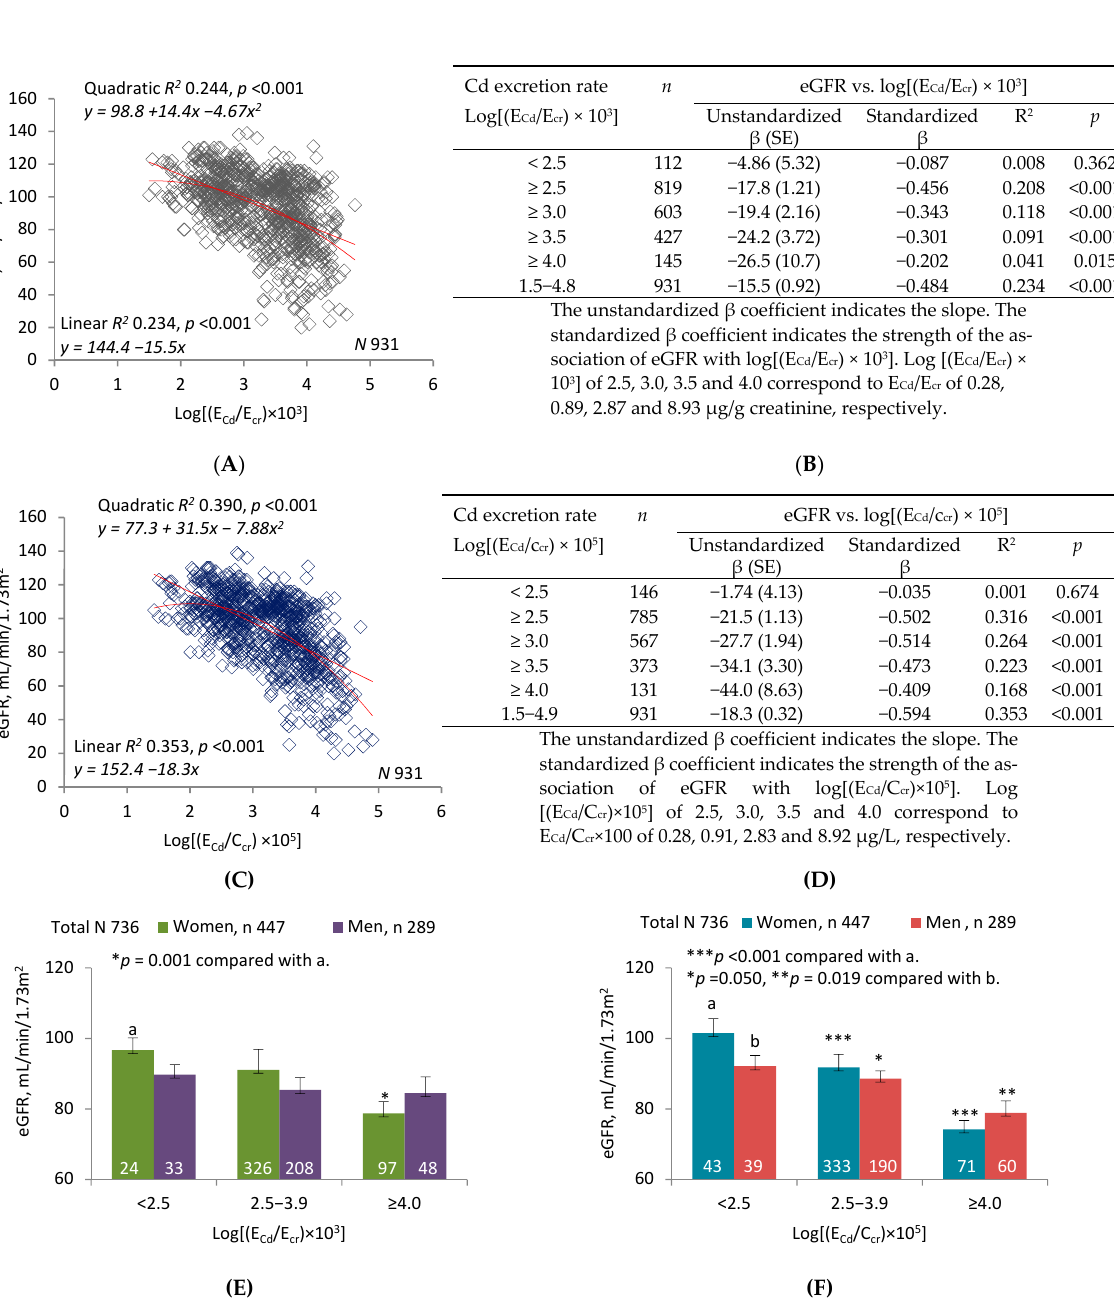
Figure 1. Inverse relationships of eGFR to parameters of Cd excretion. Parameter abbreviations are summarized at the end of the text. Scatterplots in graphs ( A , C ) relate eGFR to log[(E Cd /E cr ) × 10 3 ] and log[(E Cd /C cr ) × 10 5 ] in all subjects. Linear and quadratic equations, their respective coefficients of determination (R 2 ), and associated p -values are provided. In Table ( B ), linear relationships of eGFR to log[(E Cd /E cr ) × 10 3 ] < 2.5, ≥ 2.5, ≥ 3.0, ≥ 3.5 and ≥ 4.0 are characterized with respective values of subject number ( n ), unstandardized and standardized β , R 2 , and p . In Table ( D , linear relationships of eGFR to log[(E Cd /C cr ) × 10 5 ] of <2.5, ≥ 2.5, ≥ 3.0, ≥ 3.5 and ≥ 4.0 are characterized with respective values of subject number ( n ), unstandardized and standardized β , R 2 , and p . In graphs ( E , F ), bars represent mean eGFR in women and men grouped by ranges of log[(E Cd /E cr ) × 10 3 ] or log[(E Cd /C cr ) × 10 5 ]. The subsets thus created are identical to those constituting Cd excretion levels 1, 2, and 3 in Table 3. The letters a and b identify reference values in women and men, respectively, at the lowest rates of Cd excretion. Where appropriate, statistical comparisons are made within each gender between mean eGFR in bars a and b and mean eGFR at higher rates of Cd excretion. Geometric mean (GM) values (standard deviation, SD)